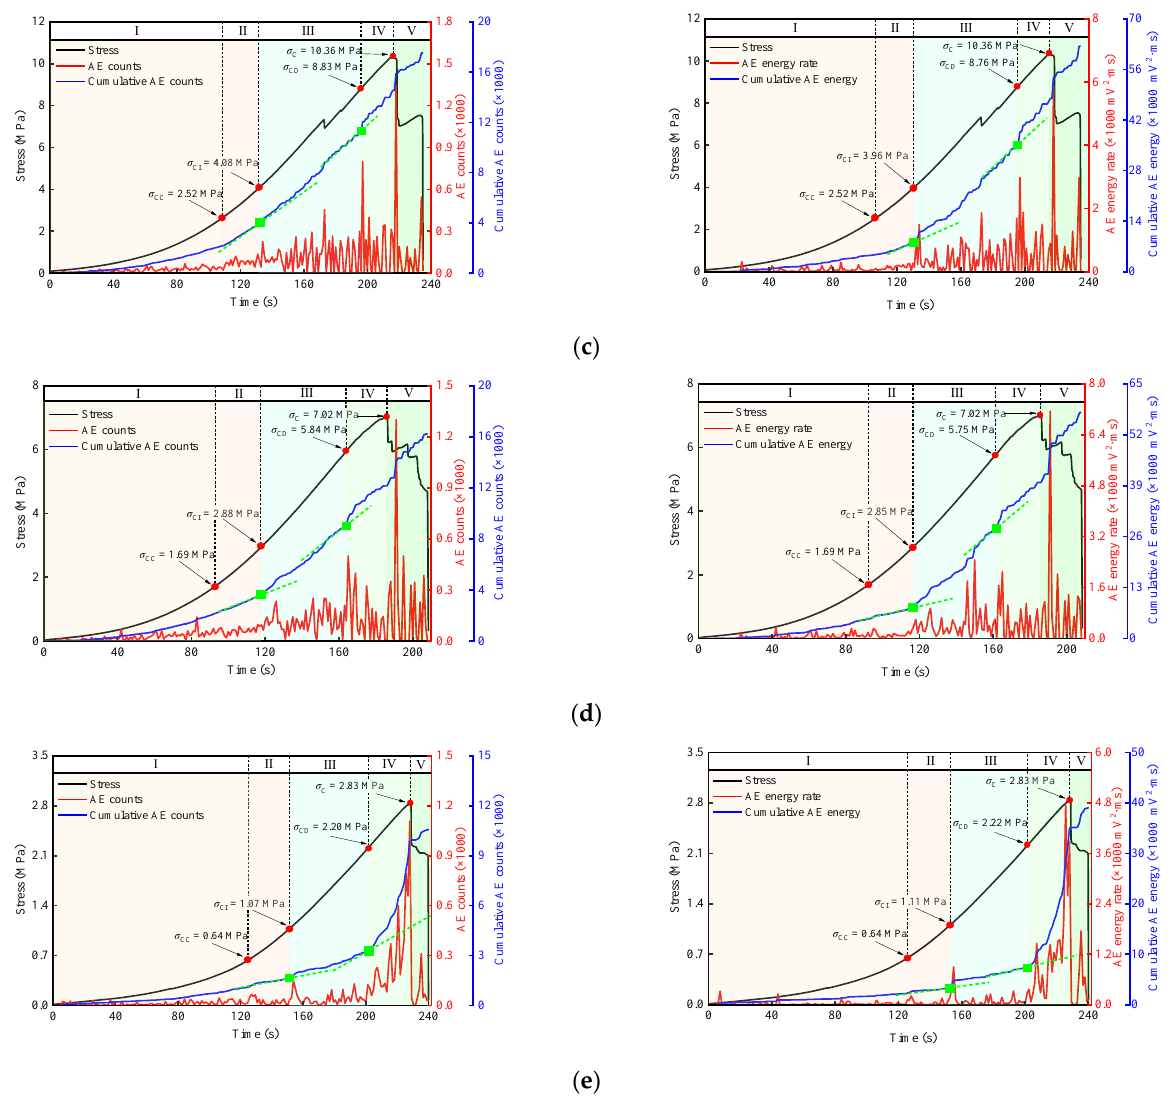
Figure 15. Curves of cumulative AE parameters (counts and energy) versus time at different moisture contents when the inclination angle was 10 ◦ : ( a ) ω = 0%; ( b ) ω = 2.42%; ( c ) ω = 5.53%; ( d ) ω = 7.55%; ( e ) ω = 10.08%. Table 2. Values of σ CC , σ CI , and σ CD at various moisture contents for θ = 10 ◦